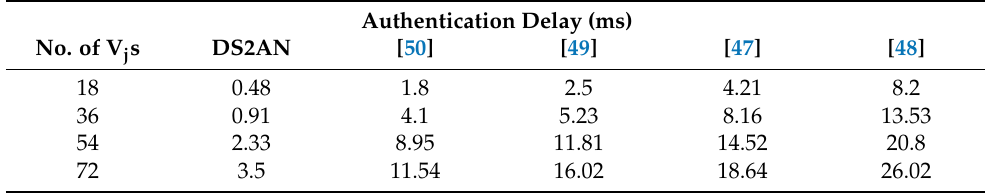
Figure 14. Comparison of Authentication delay of the DS2AN. Table 9. Comparison of authentication